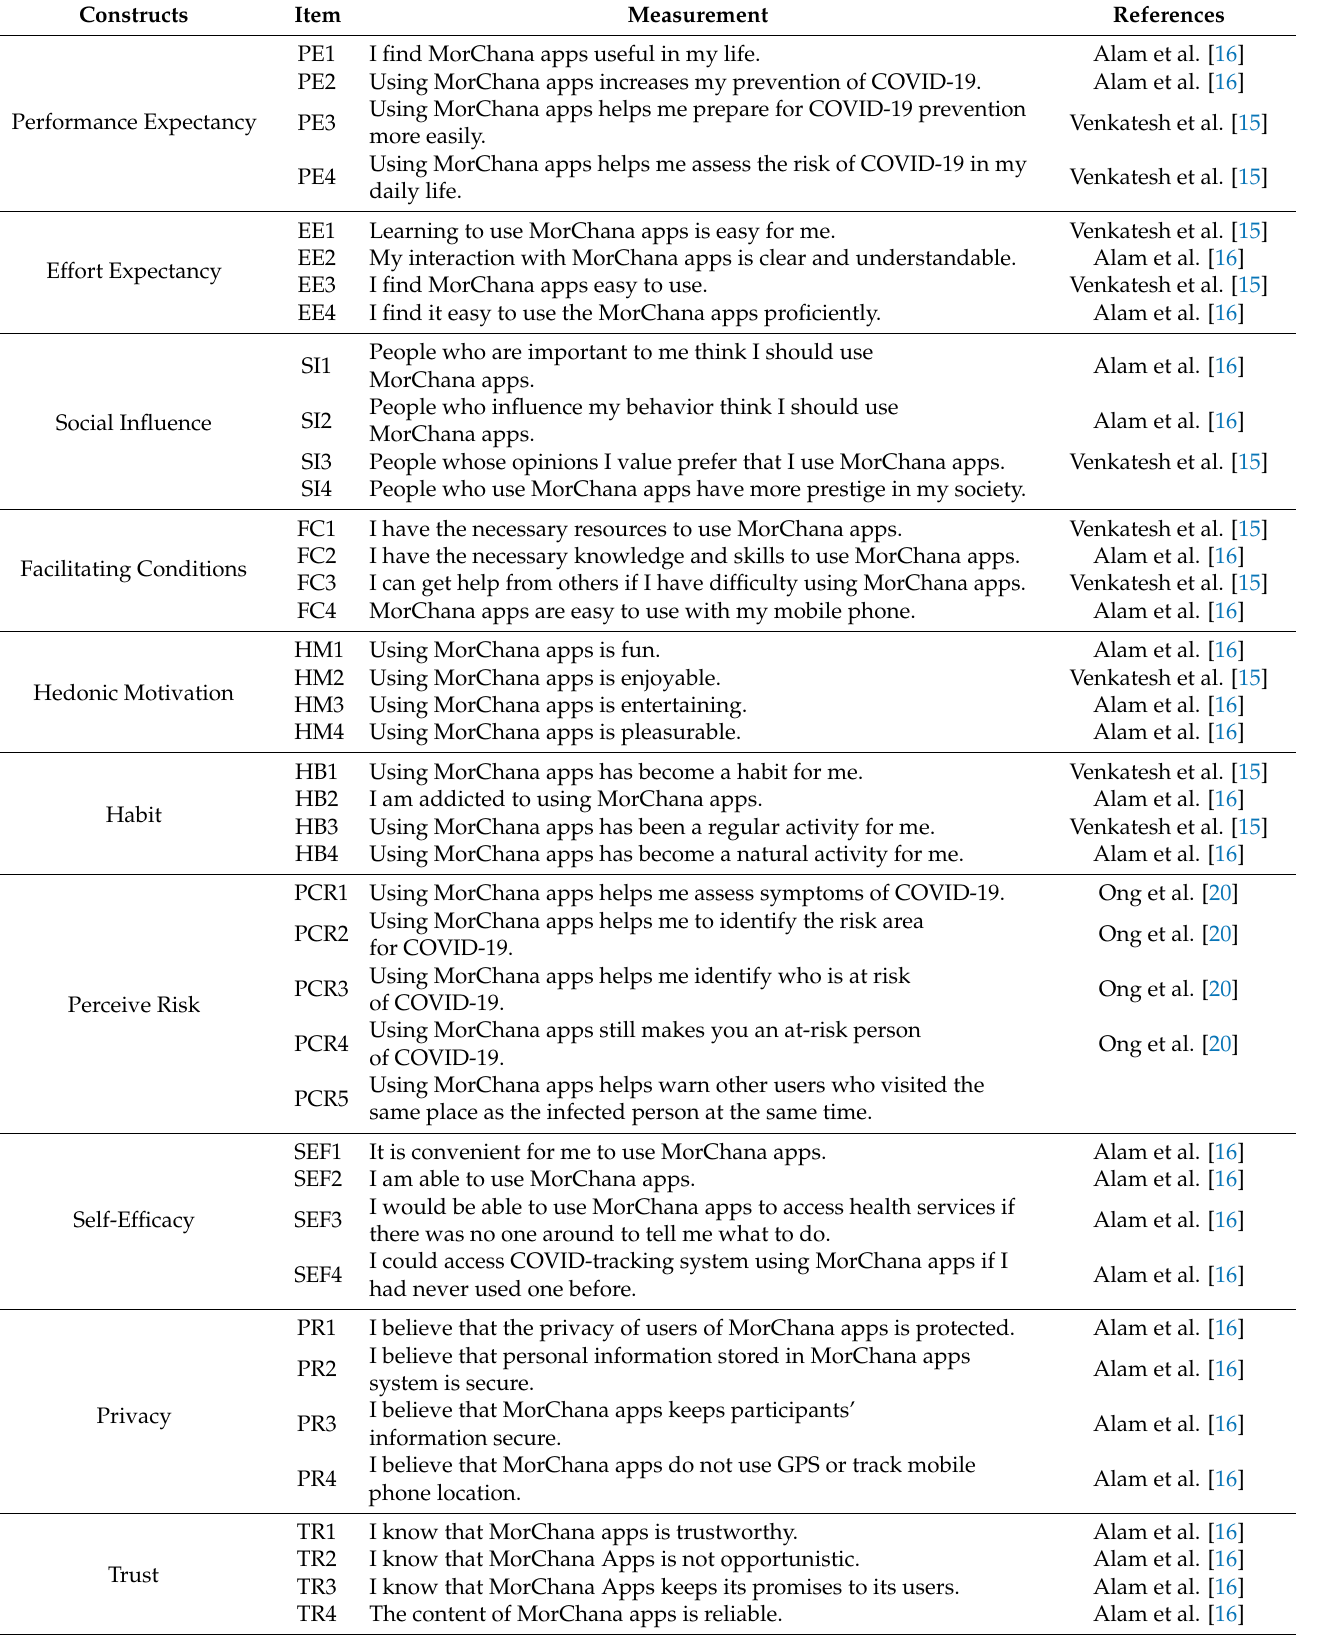
Table 2. Construct and measurement